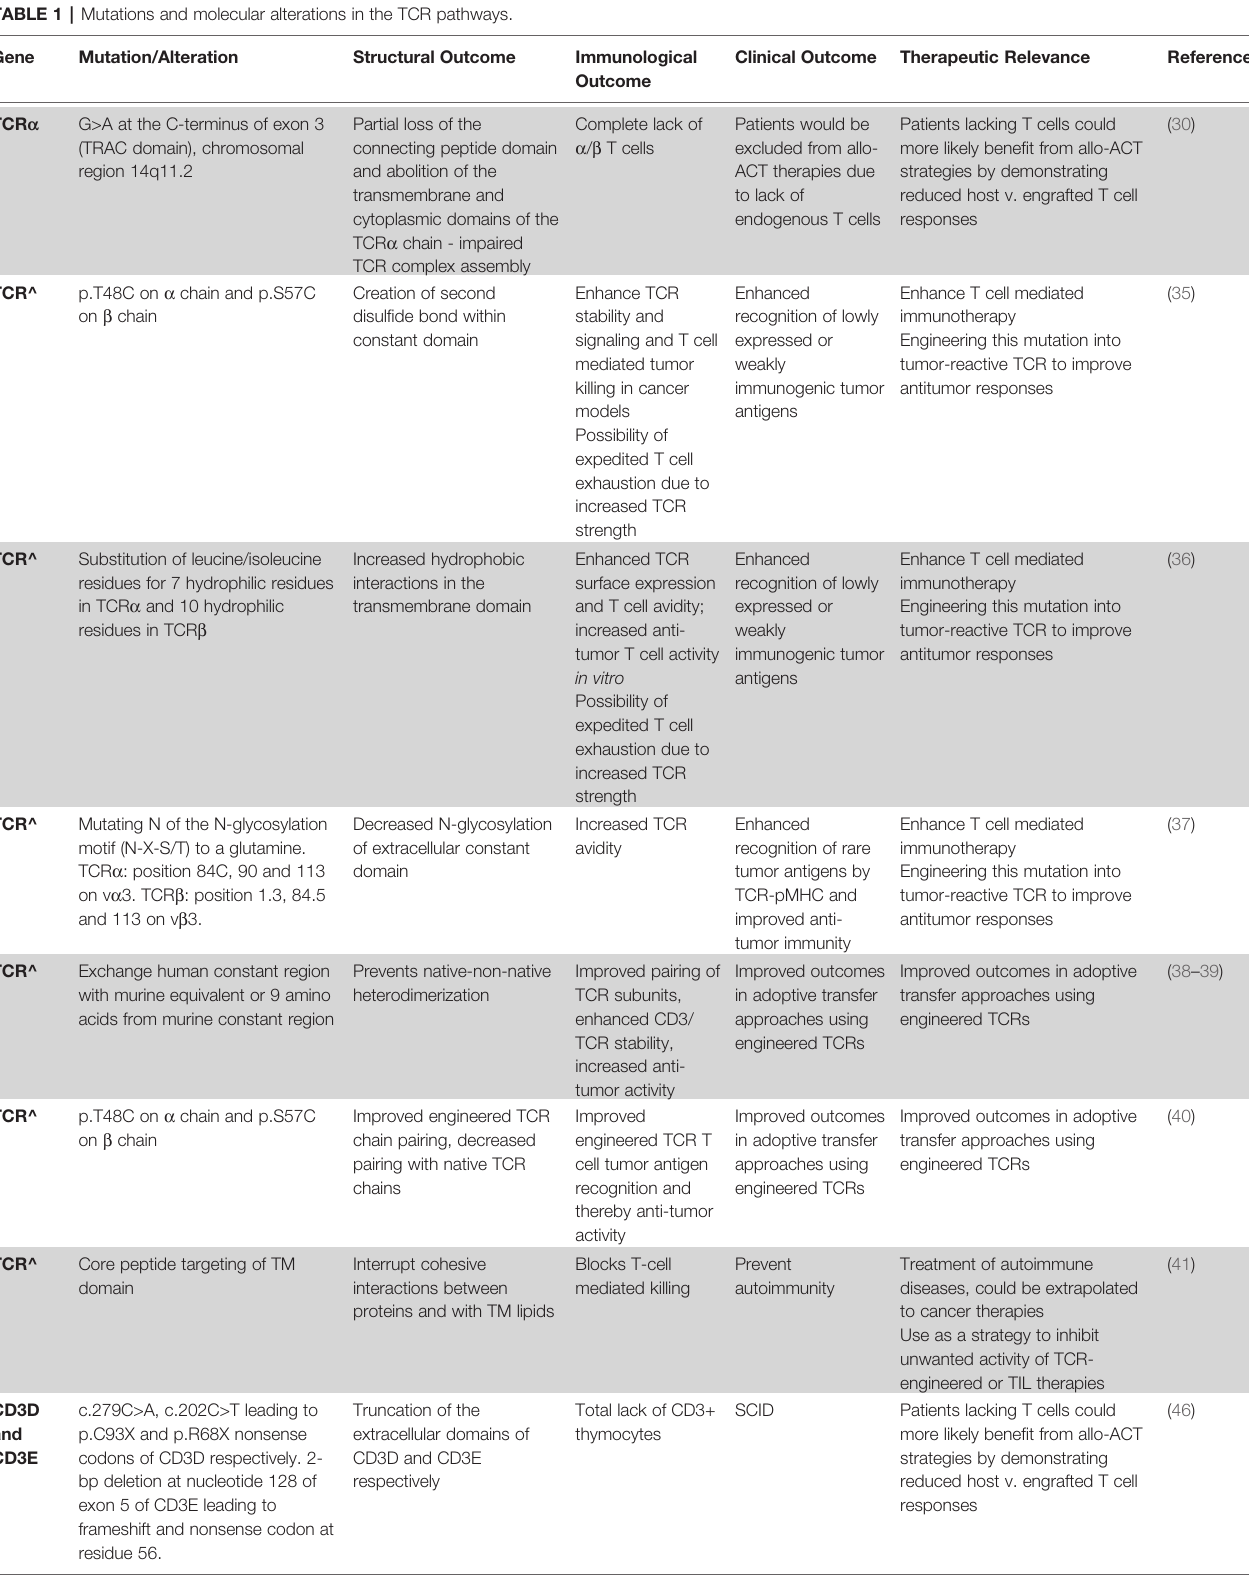
TABLE 1 | Mutations and molecular alterations in the TCR pathways.